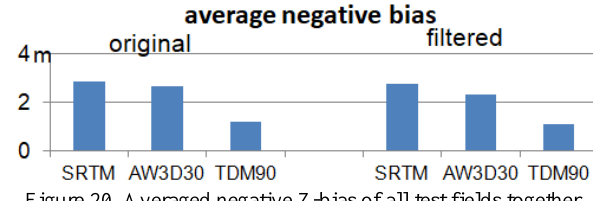
Figure 20. Averaged negative Z-bias of all test fields together